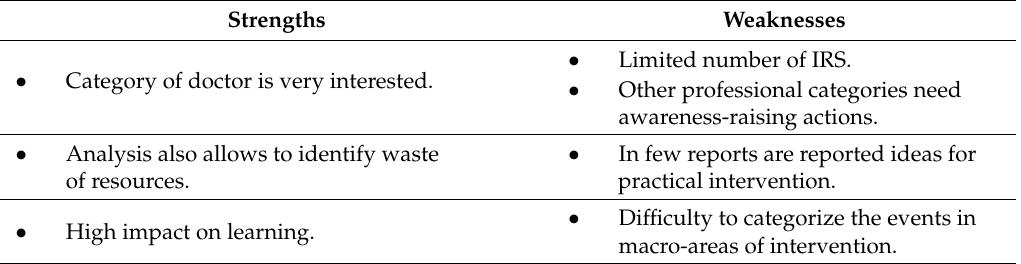
Table 7. Main strengths and weaknesses of the introduction of the incident reporting